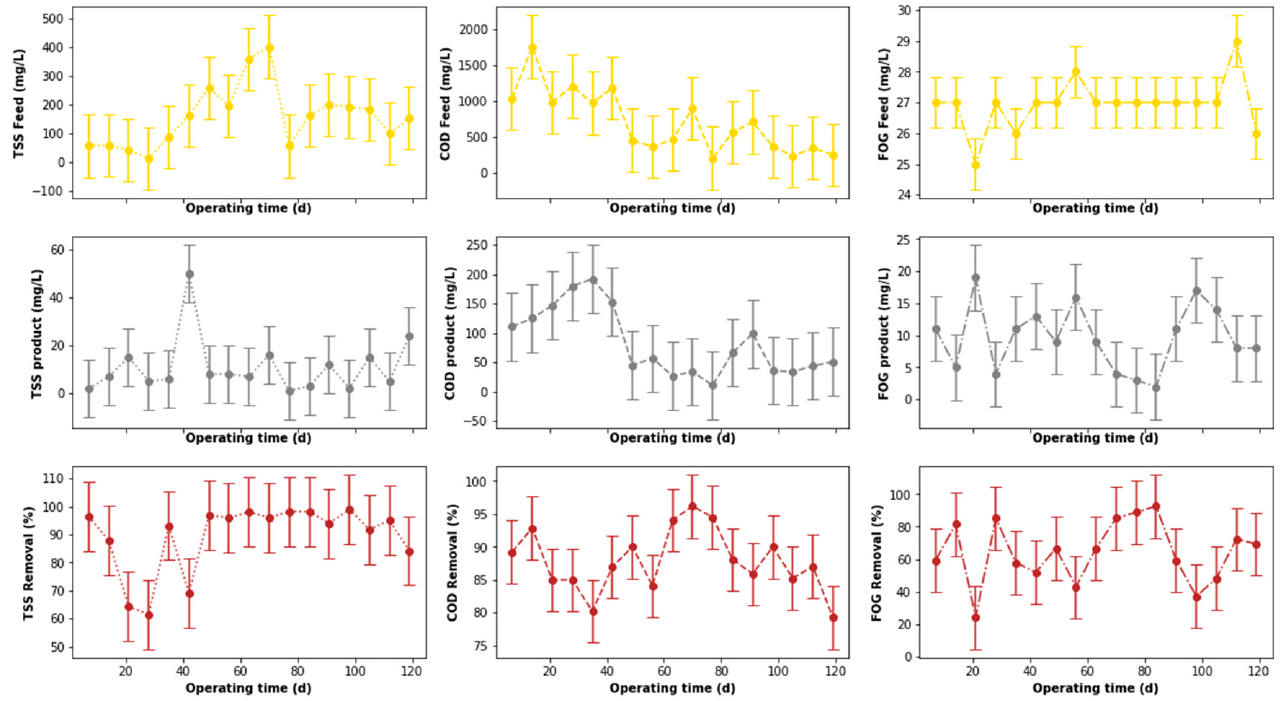
Figure 20. Performance of the MBR after the DEGBR treatment.